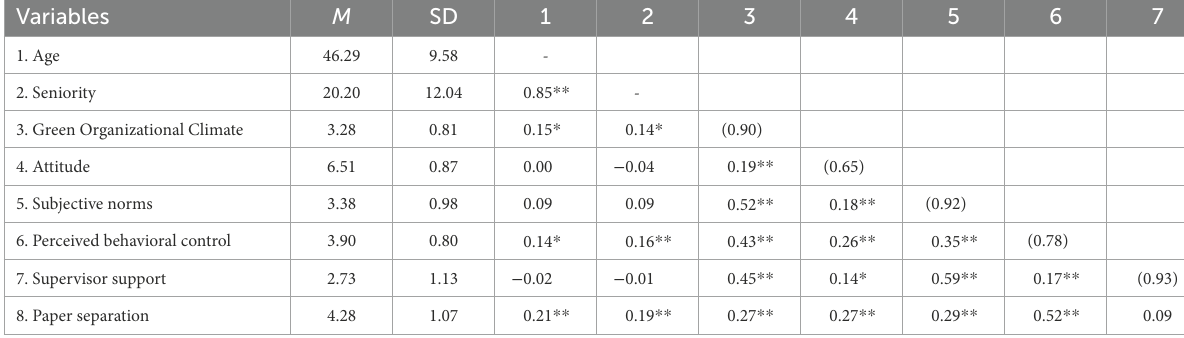
TABLE 1 Descriptive statistics, correlations, and reliabilities for paper separation. Variables